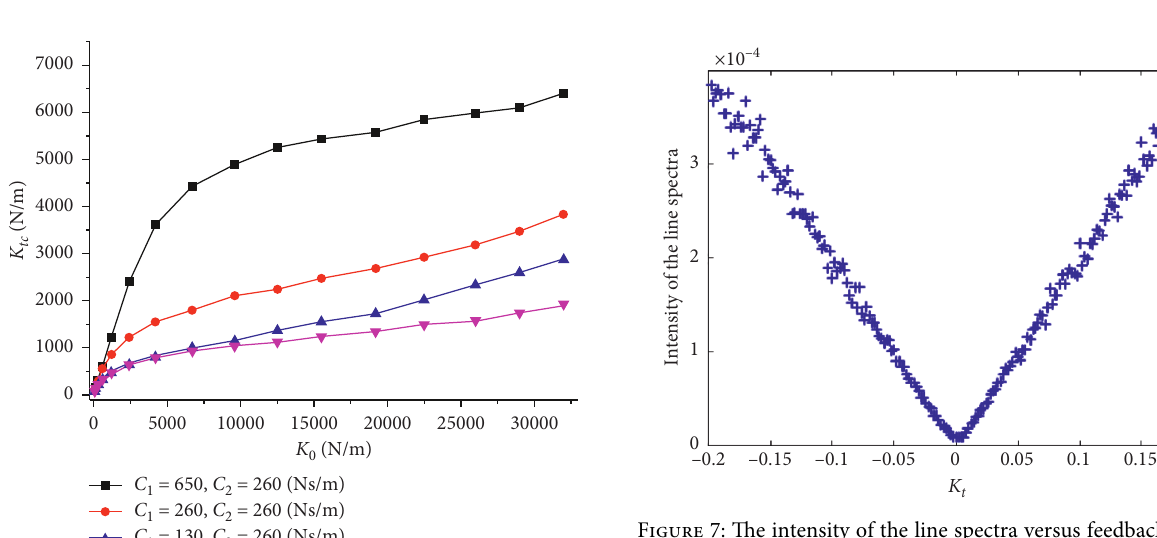
� 9600 ( N/m ) and (b) K � 2400 ( N/m ) . 0 0